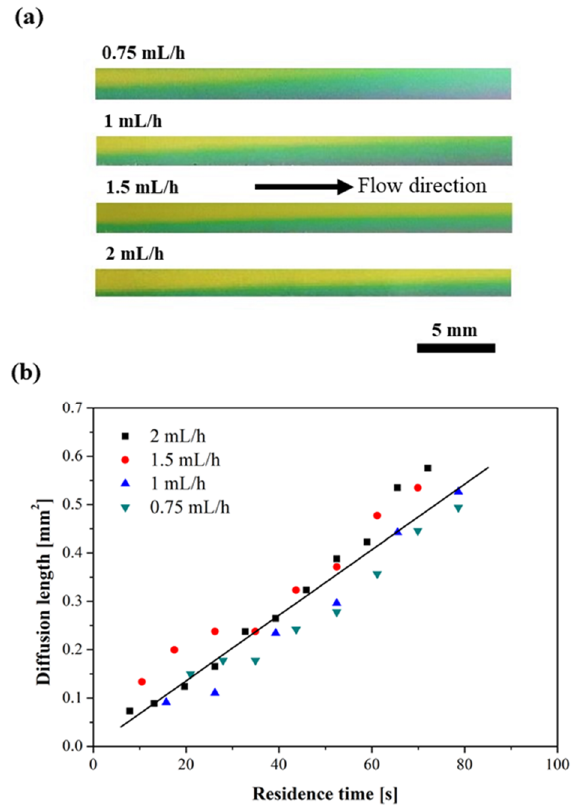
Figure 4. ( a ) Images showing the diffusion of ammonia into the collector stream at four different flow rates; ( b ) plot of the square of diffusion length over residence time along the flow path for four different flow rates (the solid line shown in the figure is the best fit to all of the data).